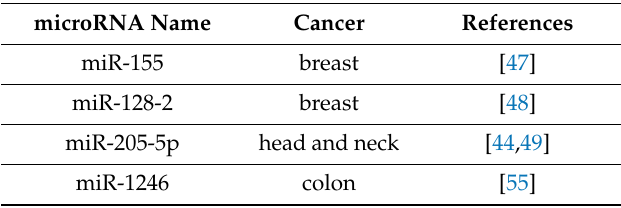
Table 1. MicroRNAs up-regulated by Gain of Function